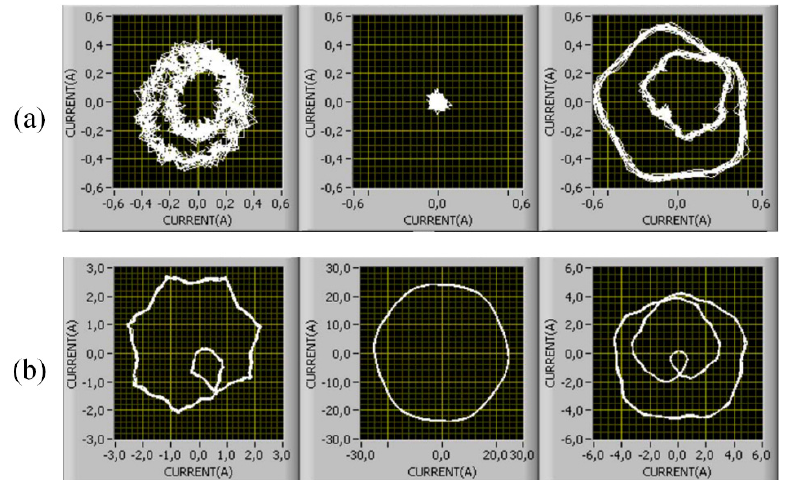
Figure 3. Online diagnostic for a 17-kVA synchronous generator based on split-phase currents [61]. ( a ) 0% SE + 0% DE. ( b ) 20% SE + 20% DE.